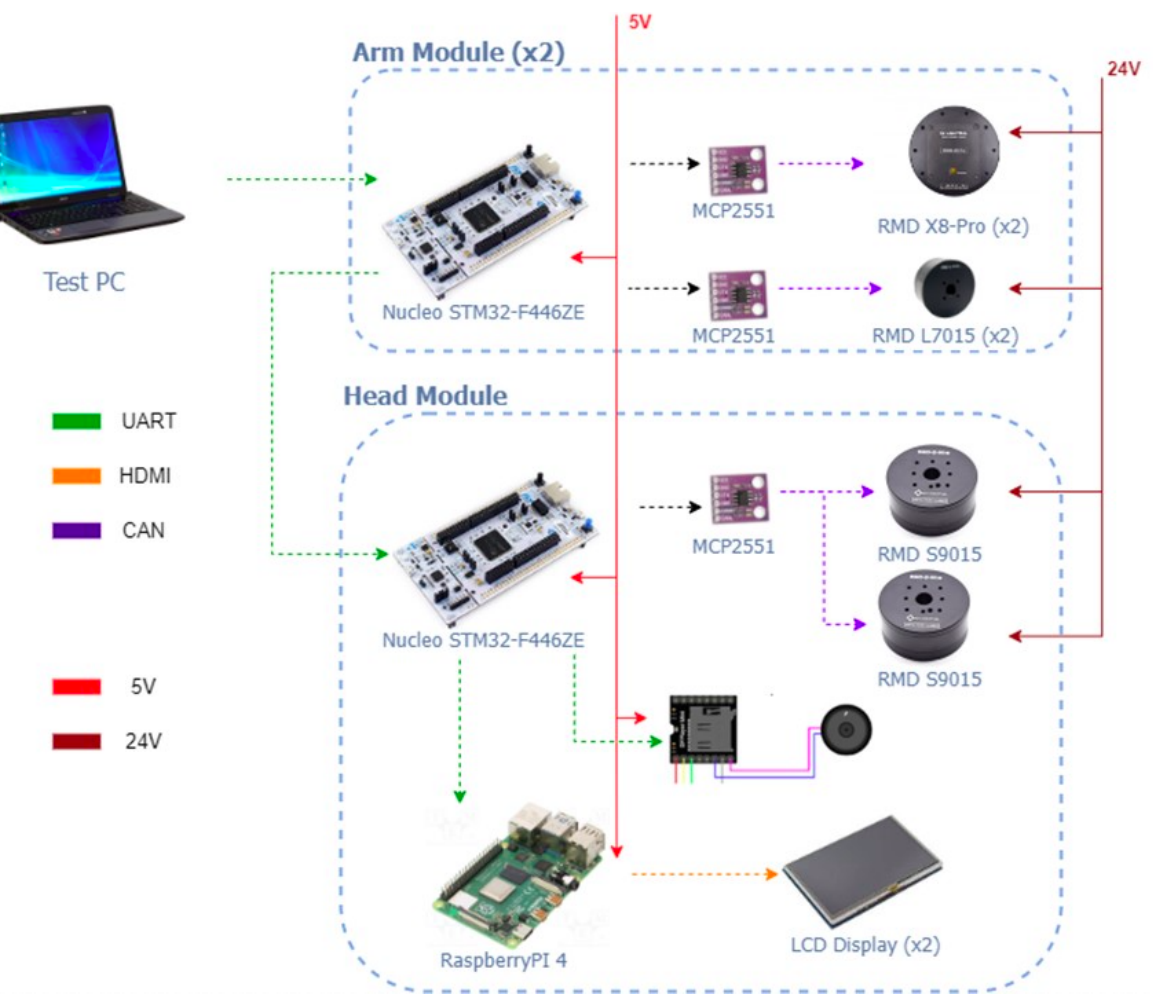
Figure 5. Hardware architecture of the robotic arms and head .